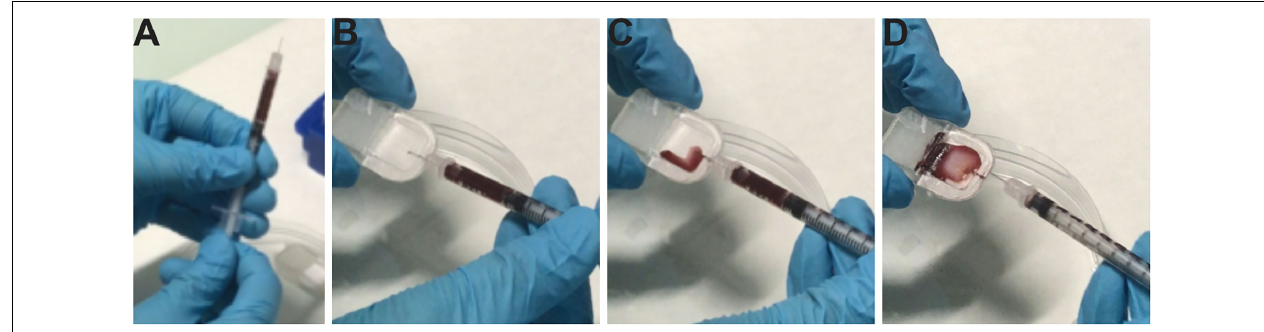
FIGURE 3 | Loading of cells in the device and different troubles encountered. (A) Loading of cells in a sterile insulin syringe. (B) Insertion of the needle into the pore of the device. (C,D) Loading cells in the cell chamber of the device and placing the device in a sterile Petri dish. For more visibility; images were not taken in the culture, and hematoxylin was placed in the